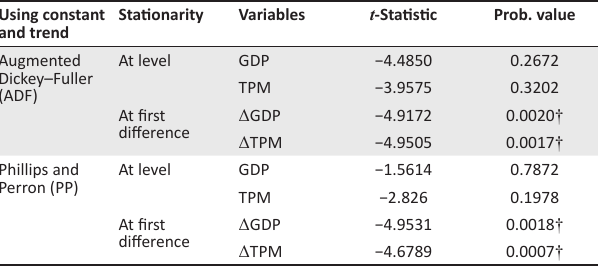
TABLE 2: Augmented Dickey–Fuller and Phillips–Perron tests. Using constant and trend